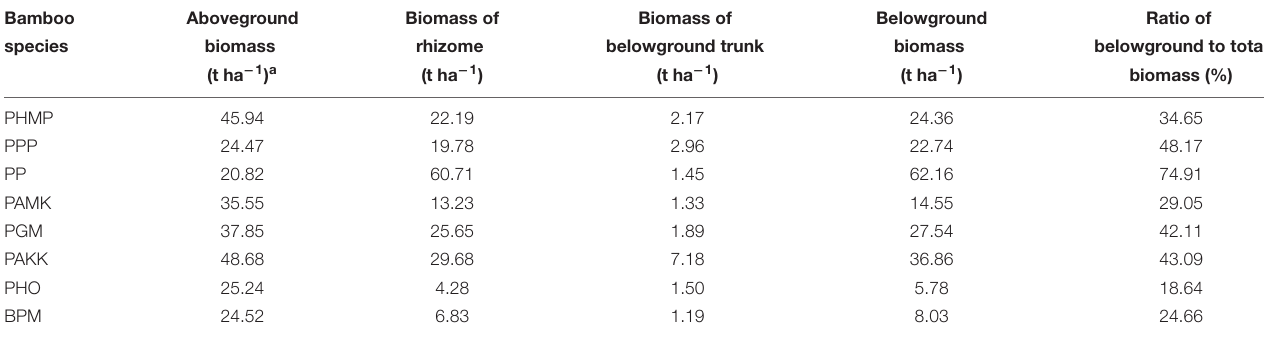
TABLE 2 | Biomass of eight monopodial bamboo species studied. Bamboo Aboveground Biomass of Biomass of Belowground Ratio of species biomass rhizome belowground trunk biomass belowground to total